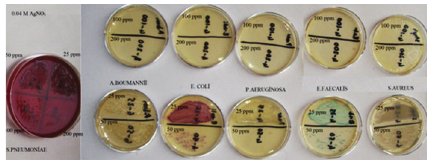
Figure 11: Antibacterial activity of